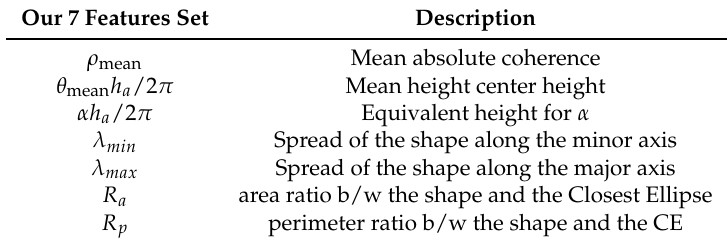
Table 1. Description of the selected geometrical parameters characterizing the PolInSAR coherence